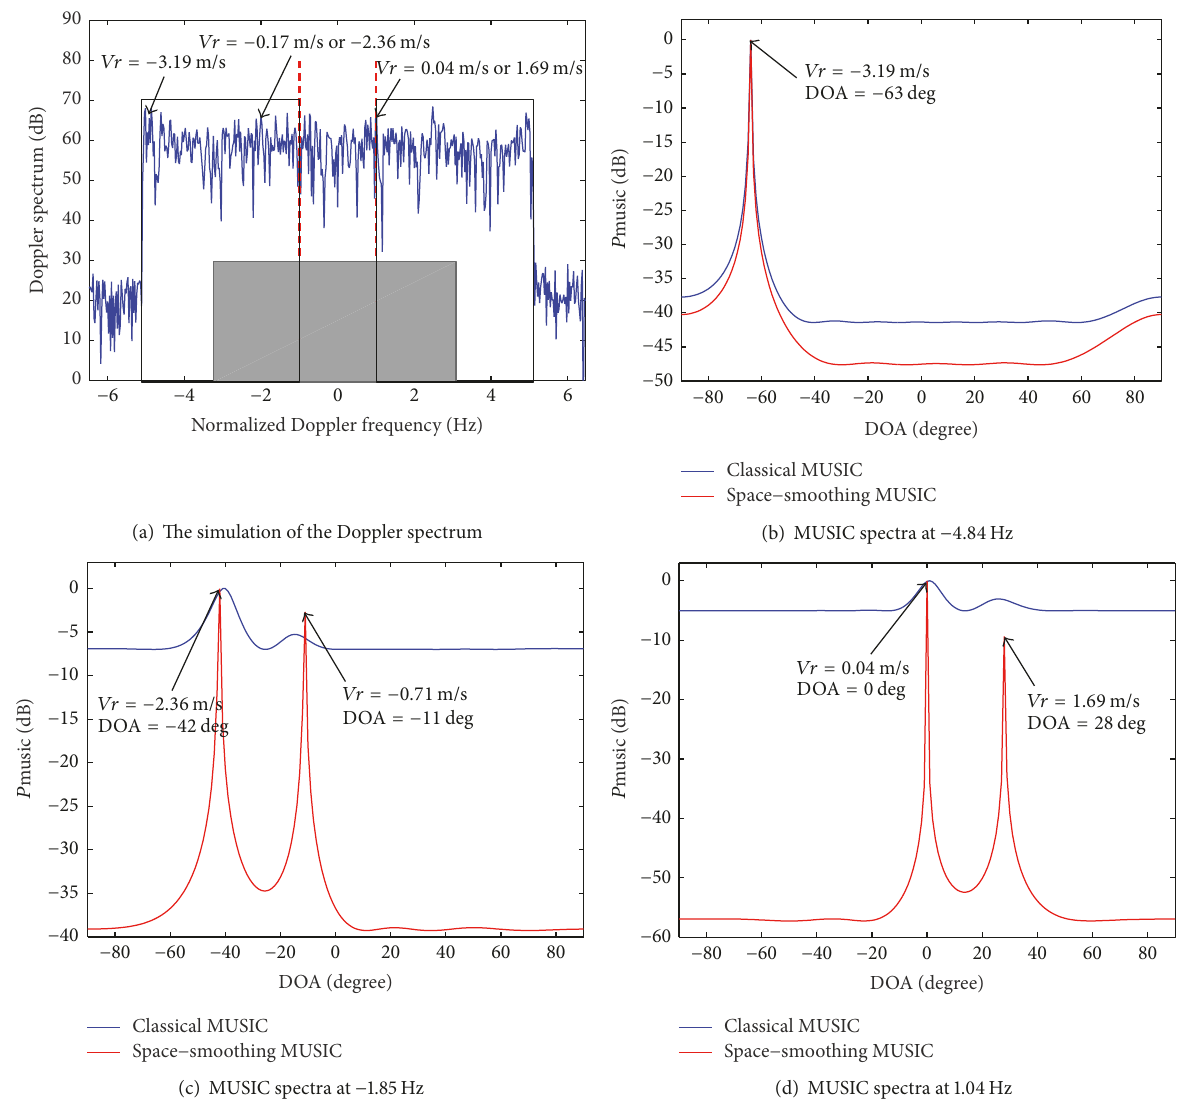
Figure 8: The simulation results of case 3